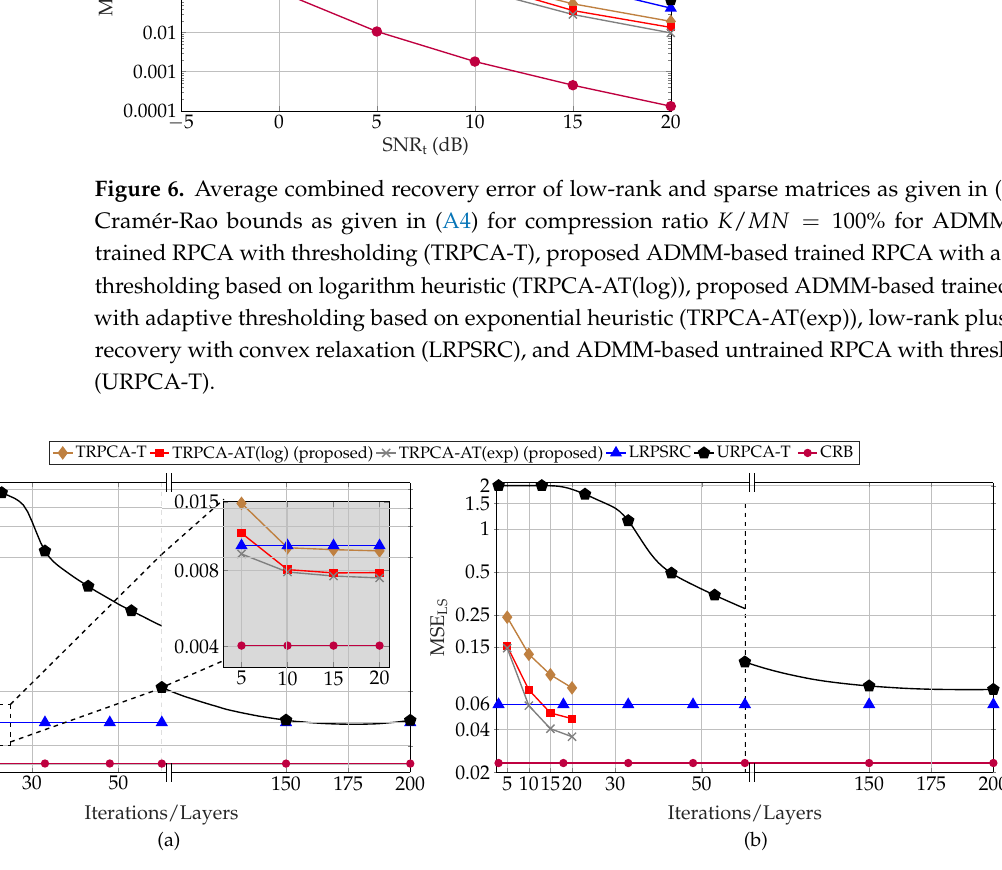
Figure 7. Average combined recovery error of low-rank and sparse matrices as given in (25) and Cramér-Rao bounds as given in (A4) for compression ratio K / MN = 50% ( a ) and K / MN = 25% ( b ) for ADMM-based trained RPCA with thresholding (TRPCA-T), proposed ADMM-based trained RPCA with adaptive thresholding based on logarithm heuristic (TRPCA-AT(log)), proposed ADMM- based trained RPCA with adaptive thresholding based on exponential heuristic (TRPCA-AT(exp)), low-rank plus sparse recovery with convex relaxation (LRPSRC), and ADMM-based untrained RPCA with thresholding